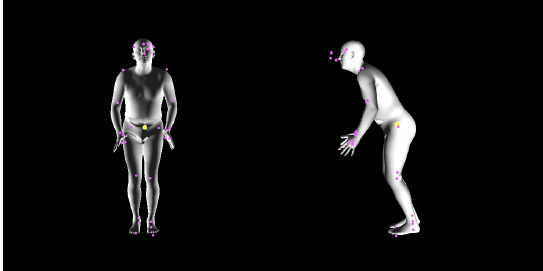
Figure 7. Example of joint